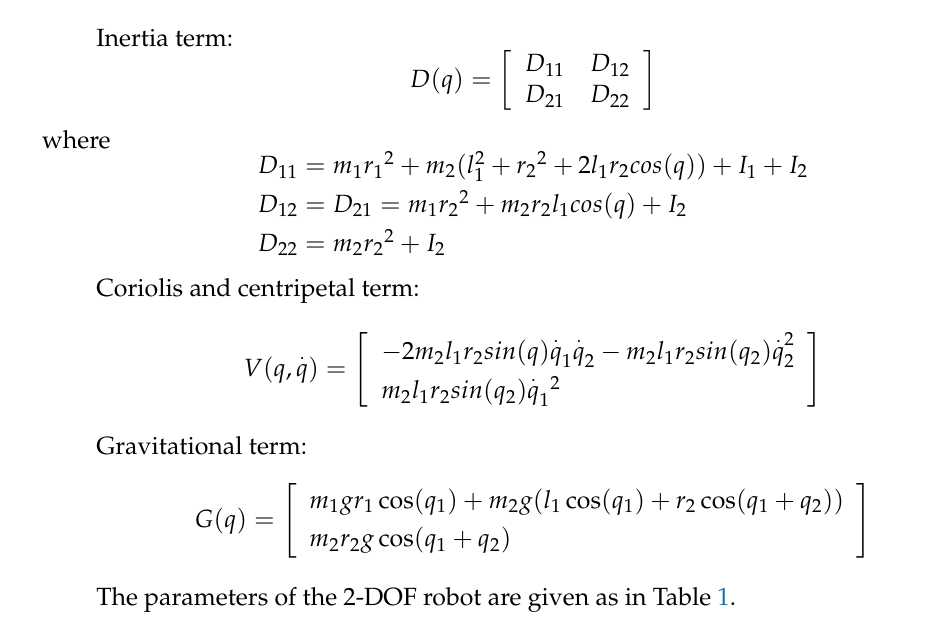
Figure 2. Configuration of the 2-DOF robotic manipulator.